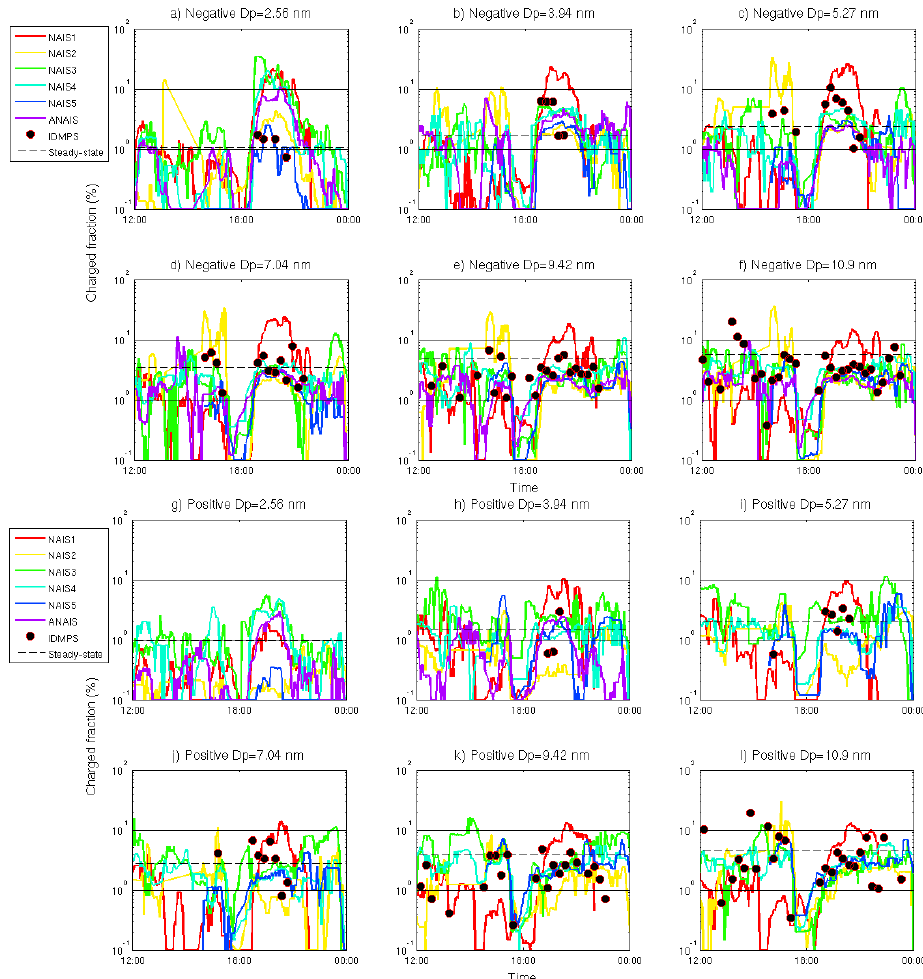
Fig. 9. Negative ( a to f ) and positive ( g to l ) charged fraction (fraction of charged particles, in percents) at 6 different diameters per polarity as a function of time for all NAISs on 12 June 2009. The charged fraction retrieved by the Ion-DMPS is shown as black circles and the steady-state charged fraction is marked with a black dashed line.